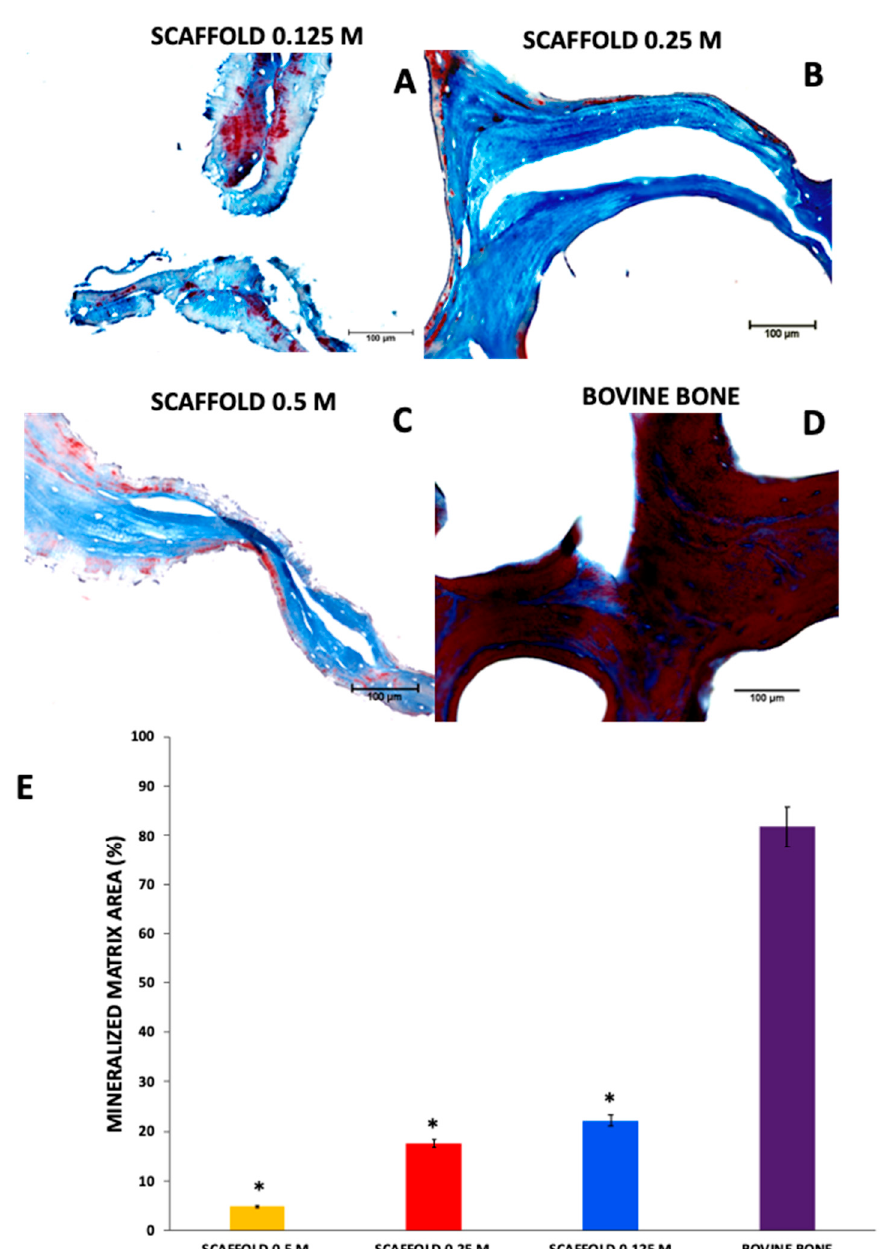
Figure 2. Histological analysis of the scaffolds and bovine bone. Optical microscope photomicrographs of histologically stained sections with Masson’s trichrome collagen fibers (blue) and mineralized matrix (red). The 0.125 M ( A ), 0.25 M ( B ), and 0.5 M ( C ) scaffolds were composed of collagen (blue). Nevertheless, in the 0.125 M scaffold, some zones indicate the presence of mineralization (red). As we expected, the bovine bone without the demineralization process ( D ) is composed of collagen (blue) and a mineralized matrix (red). The mineralized matrix area evidenced in Masson trichrome staining was calculated by Image-pro software ( E ). * p < 0.0001 compared with bovine bone without the demineralization process. Mean + SD n > 3. 40×, scale bar = 100 μ m.